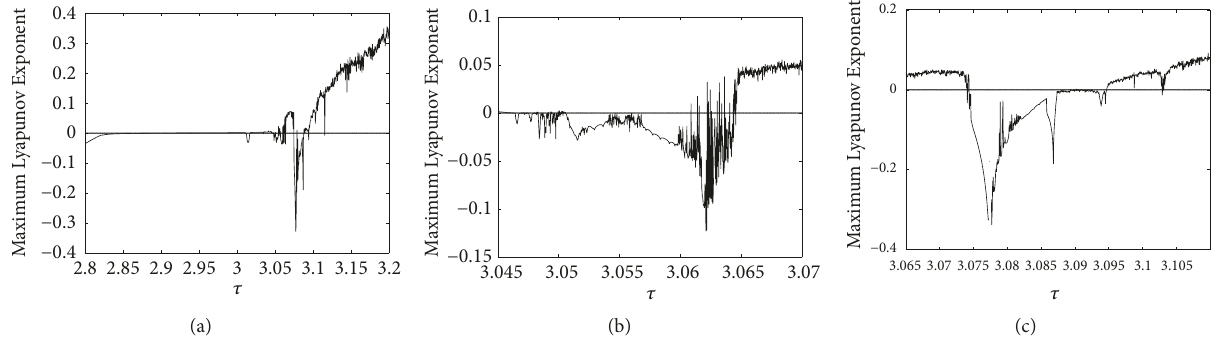
Figure 5: Diagrams of maximum Lyapunov exponent corresponding to the three graphs of Figure 4.